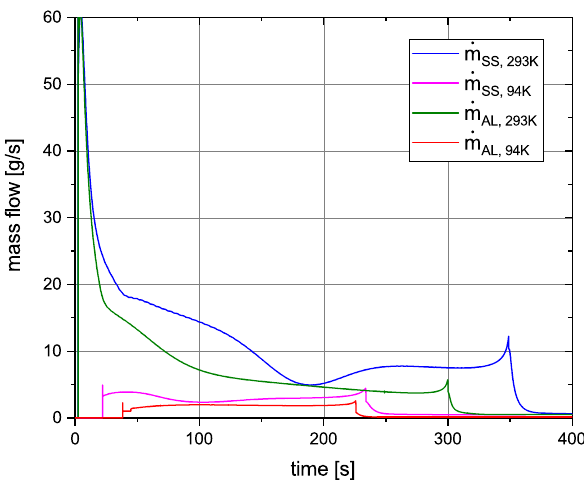
Figure 7. Mass flow through pressure relief valve.